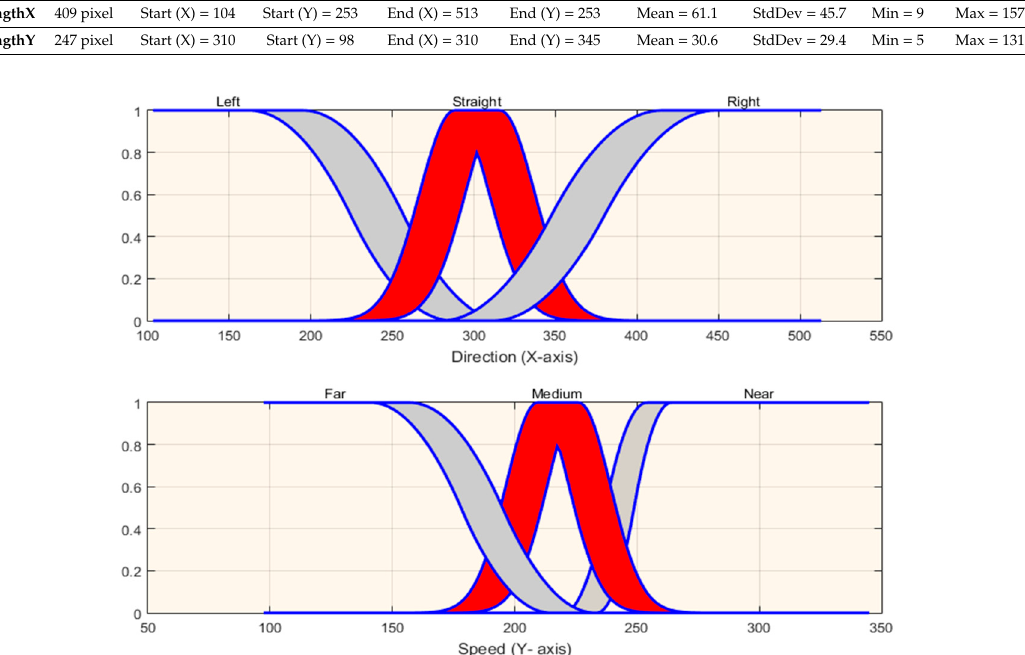
Figure 10. Membership functions of robot direction and speed.